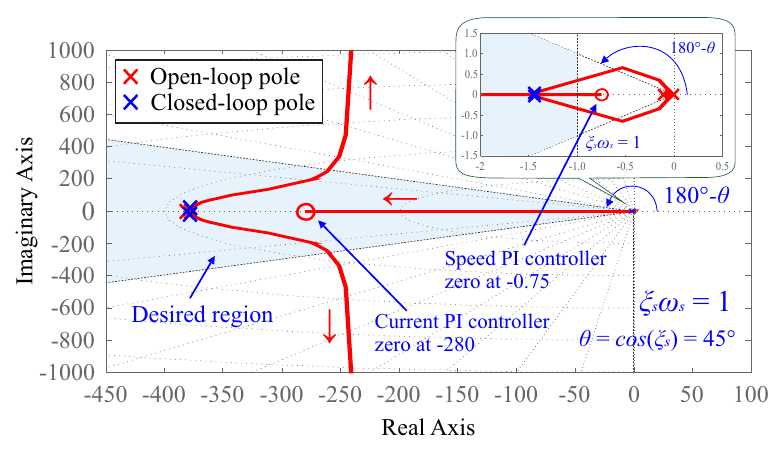
Figure 11. Root locus for speed control